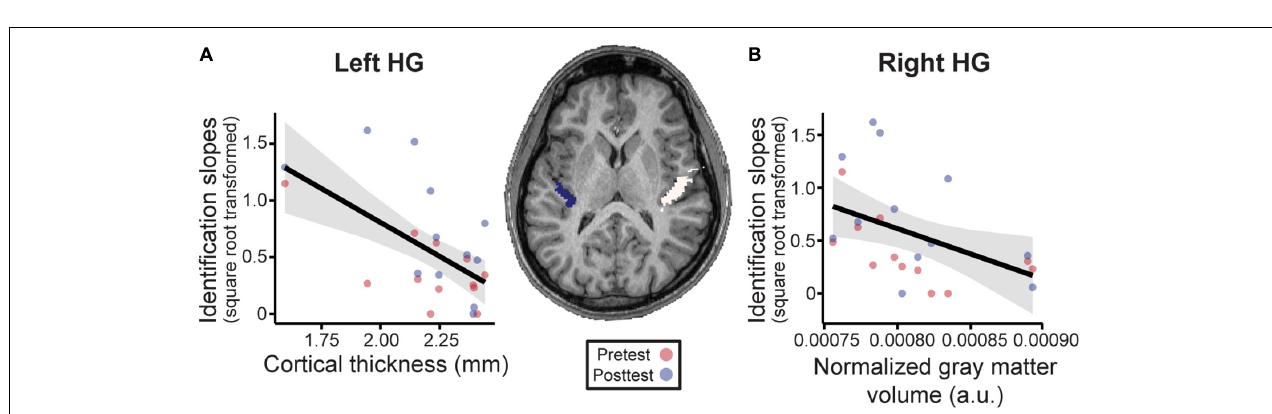
FIGURE 6 | Neuroanatomical measures in Heschl’s gyrus (HG) predict behavioral categorization performance in the learning group (Center). MRI image from a representative subject with left and right HG shown in blue and white, respectively. See Supplementary Figures 3, 4 for individual MRI images of all subjects. (A) In left HG, larger cortical thickness is associated with poorer categorization. (B) Similarly, larger normalized gray matter volumes in right HG (normalized to each individuals’ total brain volume) were associated with poorer behavioral categorization. Data points indicate individual subject identification slopes (values are square-root transformed). a.u. = arbitrary units. Shading = 95%